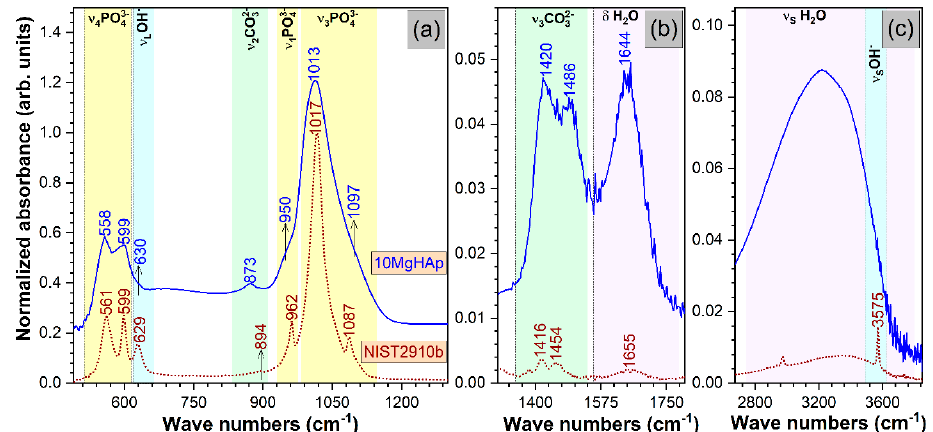
Figure 10. The comparative Fourier-transform infrared (FTIR) spectroscopy in attenuated total reflectance (ATR) mode spectra of the 10MgHAp and National Institute of Standards and Technology SRM2910-b samples in three relevant wave number regions: ( a ) 500–1300 cm − 1 ; ( b ) 1300–1800 cm − 1 ; and ( c ) 2700–3800 cm − 1 . Nanomaterials 2019 , 9 , x FOR PEER REVIEW